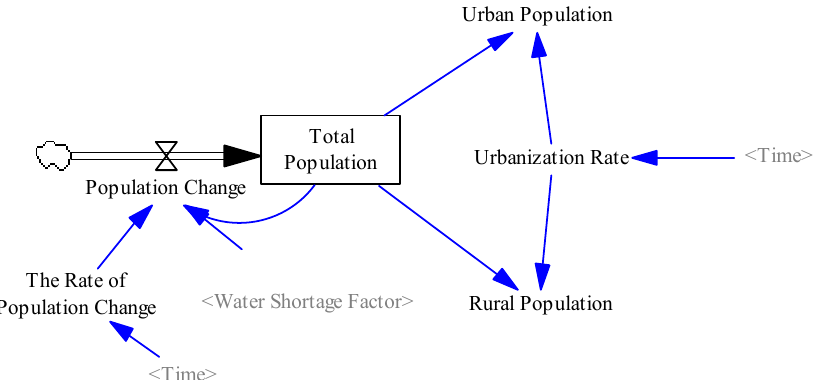
Figure 1. System dynamics flowchart of the population subsystem.